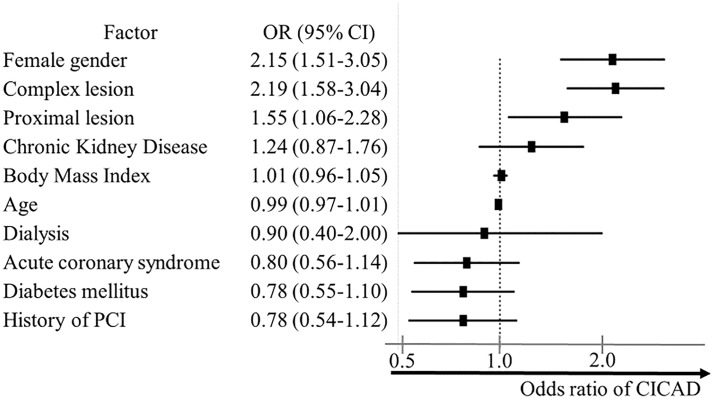
Predictors of catheter-induced coronary artery dissection.Multivariable predictors of iatrogenic coronary artery dissection (CICAD). Adjusted OR (point estimate) and 95% CI (error bars) indicate the likelihood ratio of CICAD from logistic regression. OR > 1 indicates increased odds of CICAD. CICAD = catheter-induced coronary artery dissection; OR = odds ratio; PCI = percutaneous coronary intervention.